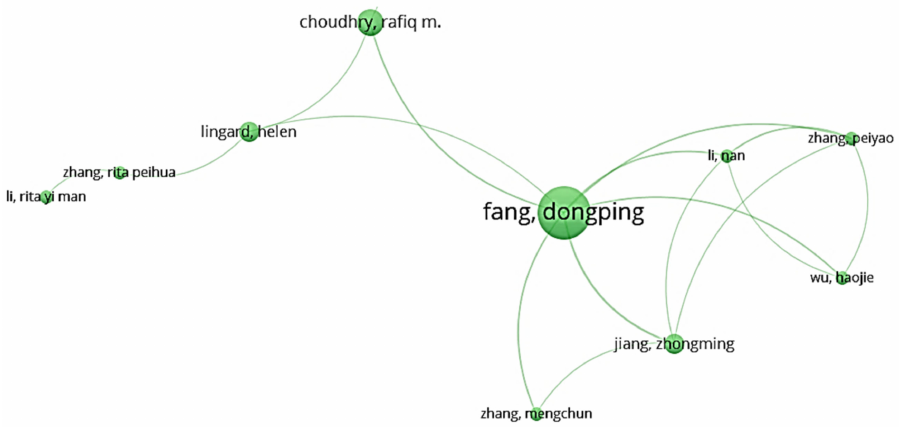
Figure 3. Co-authorship network of cluster 2.